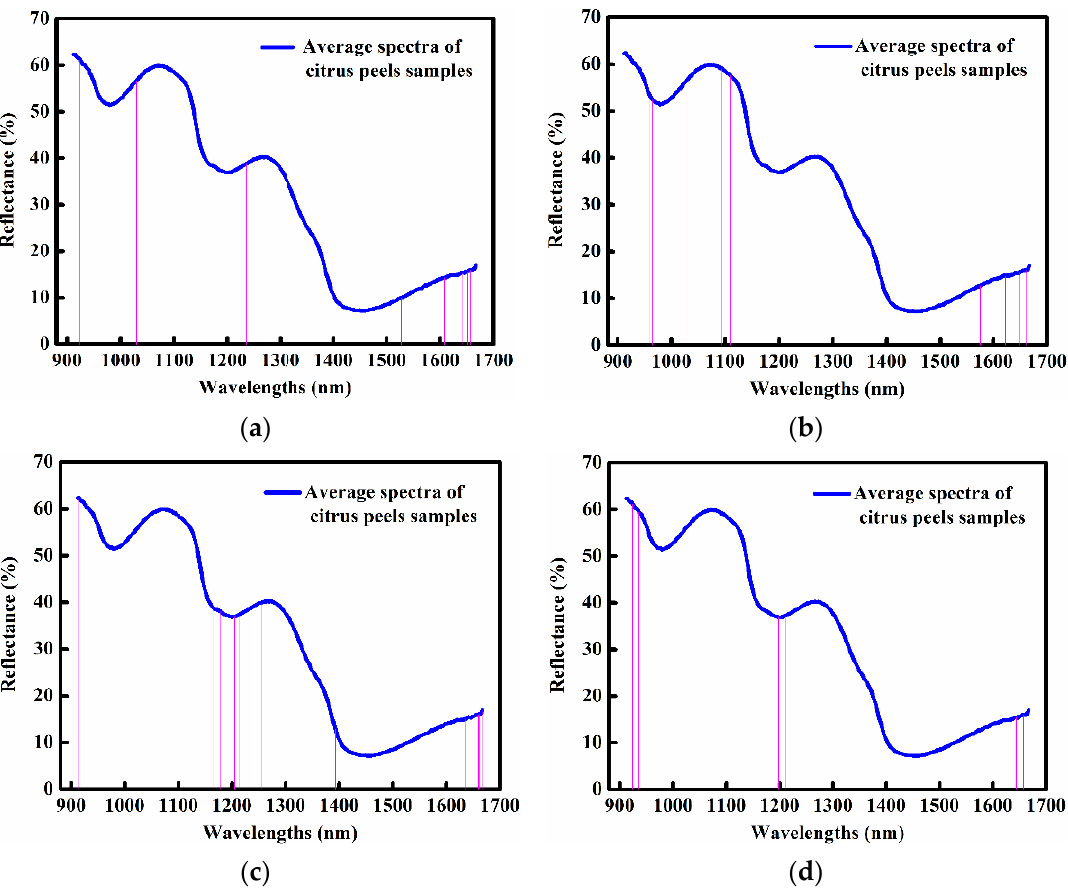
Figure 3. Specific locations of selected optimal wavelengths. ( a ) RC method; ( b ) SR method; ( c ) SPA method; ( d ) CARS method.